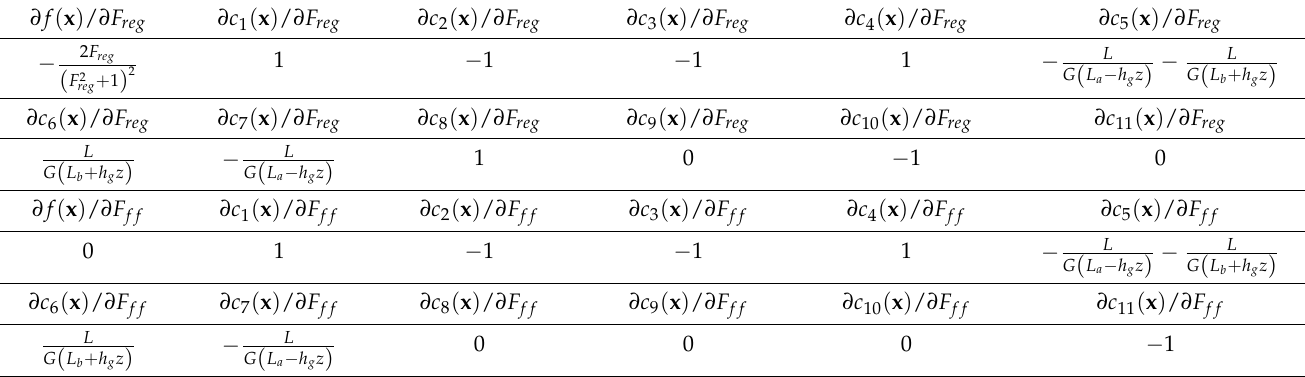
Table 2. First order partial derivative of the objective function and constraints with respect to x i